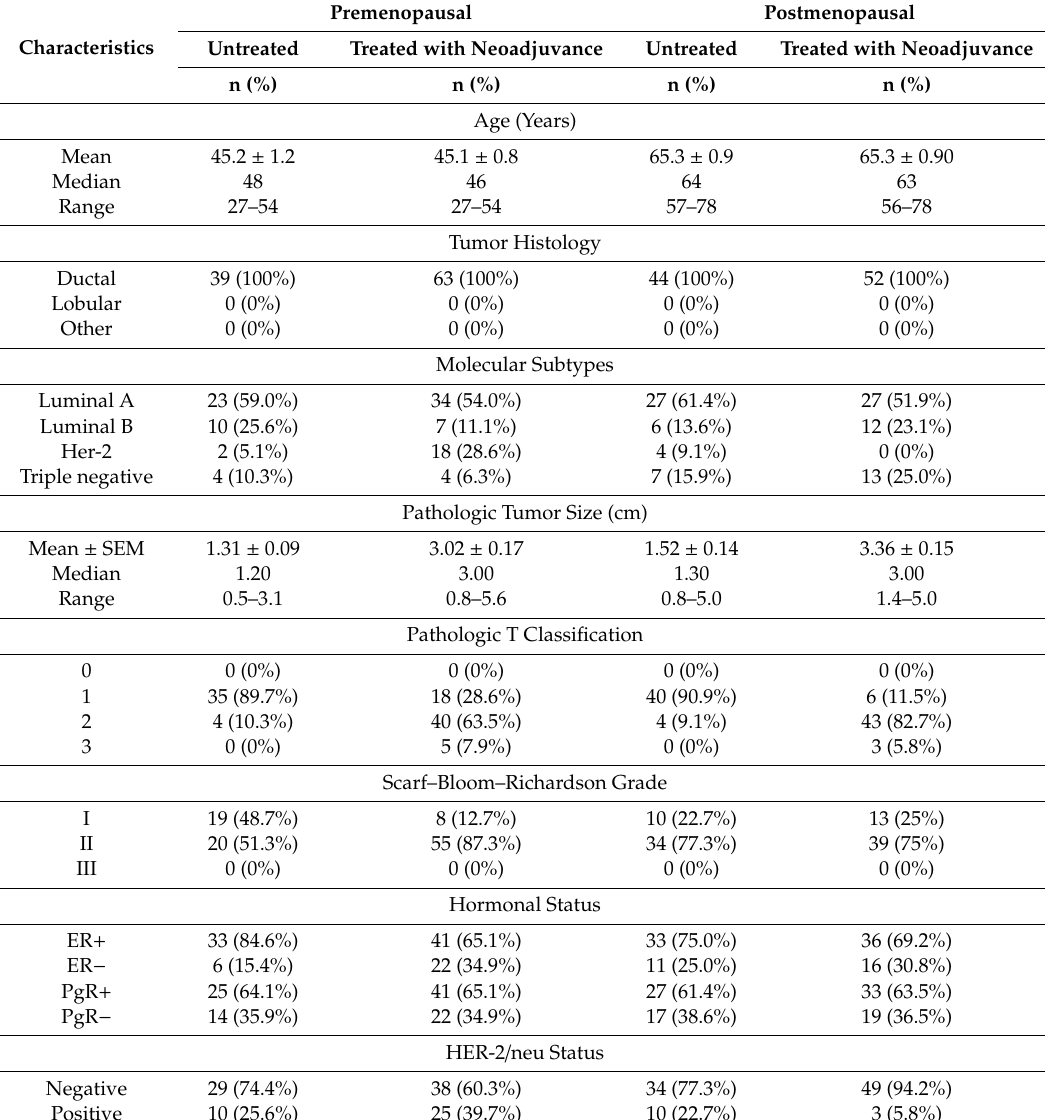
Table 1. Clinicopathological description of the patients involved in this